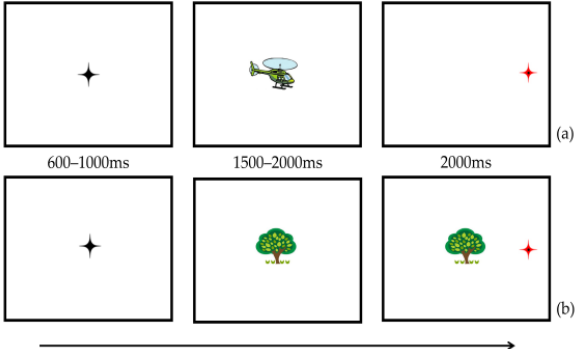
Figure 3. Schematic examples of the GOP task in the baseline condition ( a ) and overlap condition ( b ) of Experiment 2. The helicopter represents a CI-related item, and the tree represents a non-CI item.